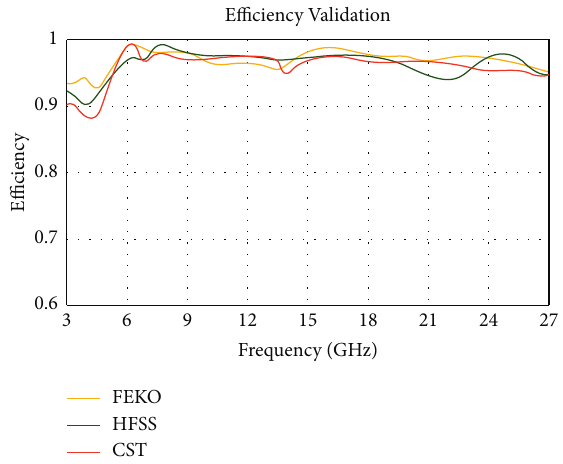
Figure 11: Validation of efficiency curve of the proposed Vivaldi antenna.